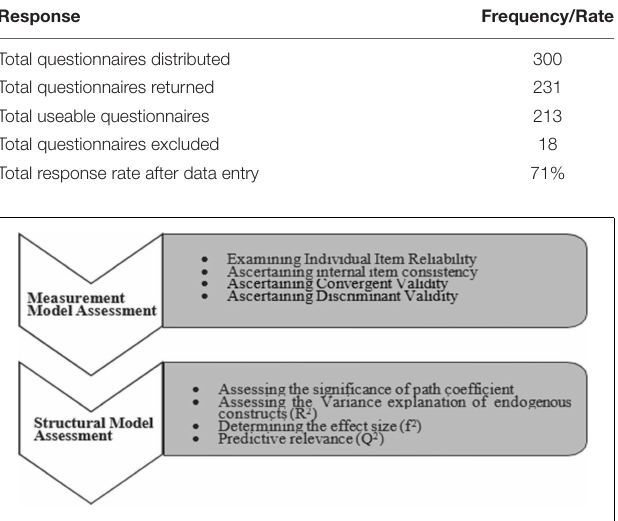
FIGURE 1 | A two-step process of PLS path model assessment. Source: Henseler et al. (2009).